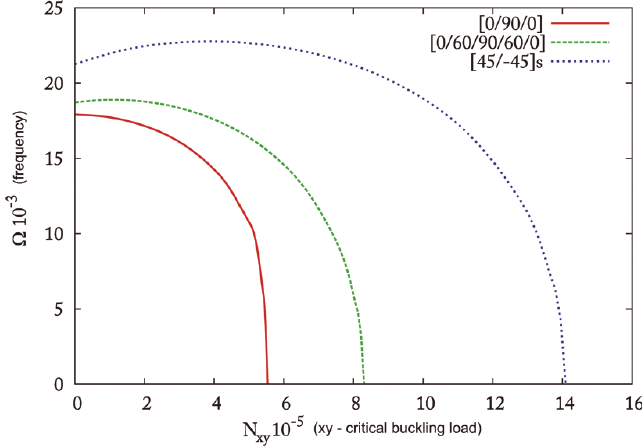
Fig. 7. Plate free frequencies with varying shear load, PS , SSSS , a/h = 30, a = b , LD2.